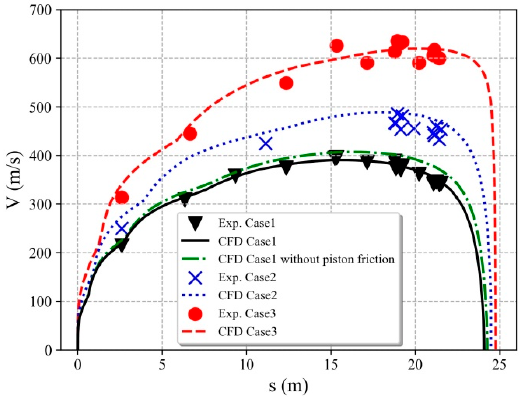
Figure 7. Piston speed versus piston travel distance.